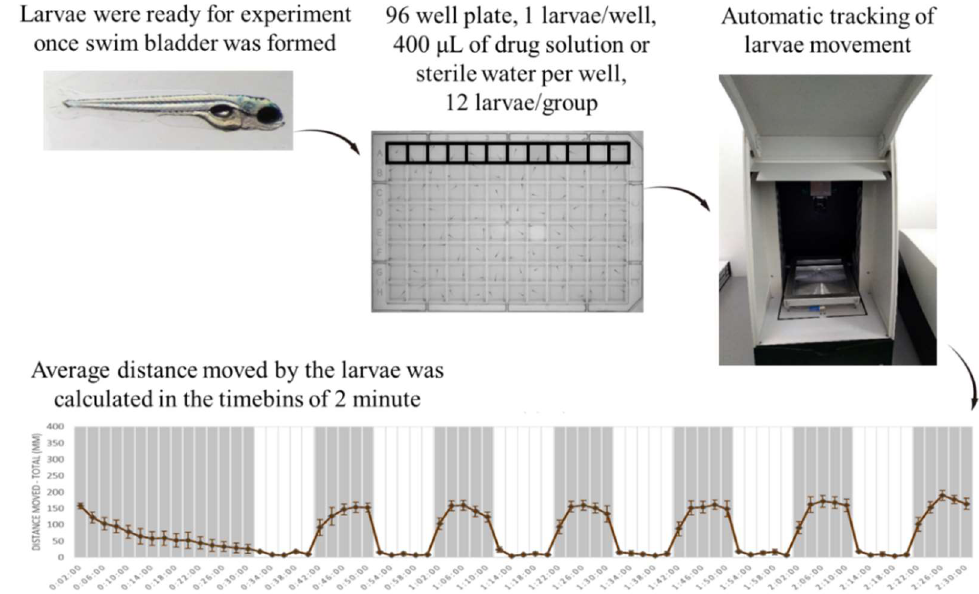
Figure 1. General scheme of the light-dark locomotion test. Zebrafish larvae were placed in a 96-well plate with one larva per well and 300 µ L of fish water. The plate containing the larvae was then placed in a Danio vision observation chamber following which the high-throughput tracking of zebrafish larvae was performed. The experiment duration was 2 h and 30 min and consisted of: 30 min of acclimatization, followed by 6 cycles of alternating light and dark periods. Each point in the graph represents the mean ± SEM (standard error of mean) of the distance moved by zebrafish larvae in 2 min of time bins. The shaded part represents the dark period and the unshaded part represents the light period. The total number of embryos used was 12 ( n = 12).